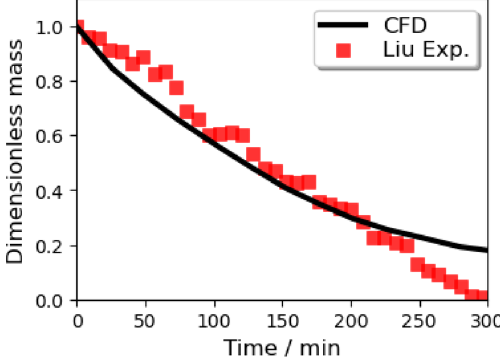
Figure 14. Dimensionless mass losses of water droplets at RH = 84% 57 .